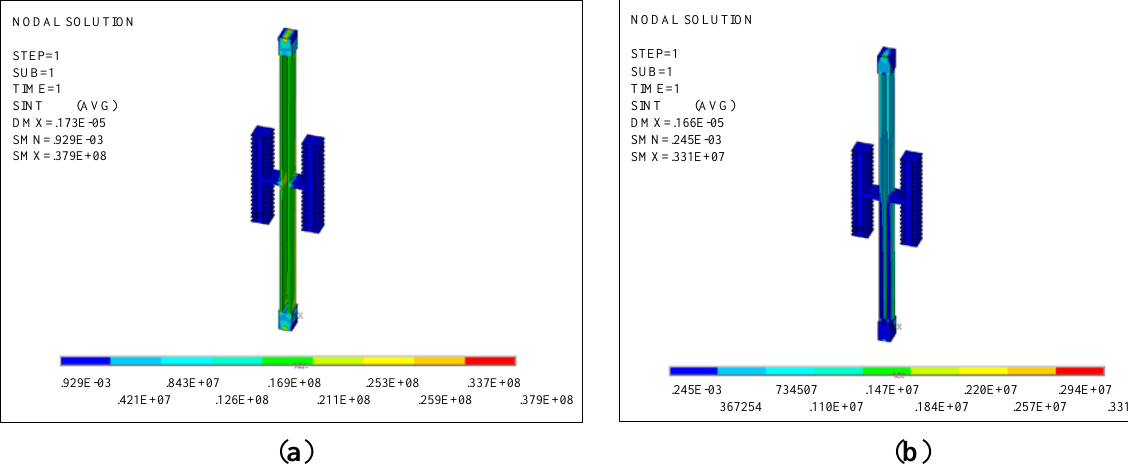
Figure 9. T he stress distributions of the two DEFT structures at 400 °C ( a ) The accelerometer equipped with the common DETF structure; ( b ) The accelerometer equipped with the improved DETF structure.